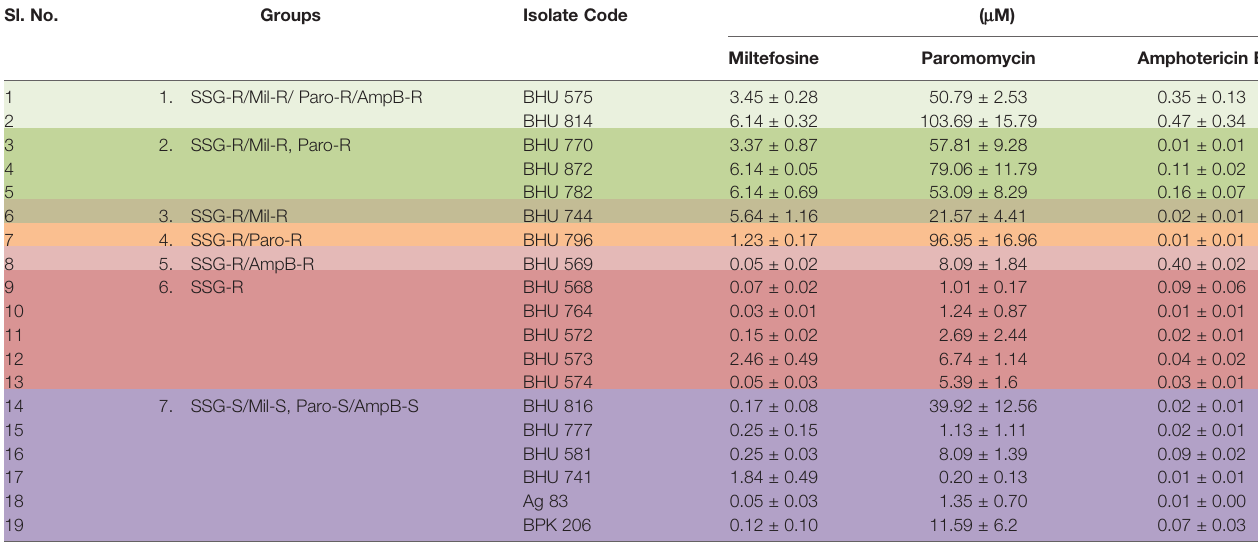
TABLE 1 | Susceptibility of intracellular amastigotes (EC 50 ) to different antileishmanial drugs. Sl.